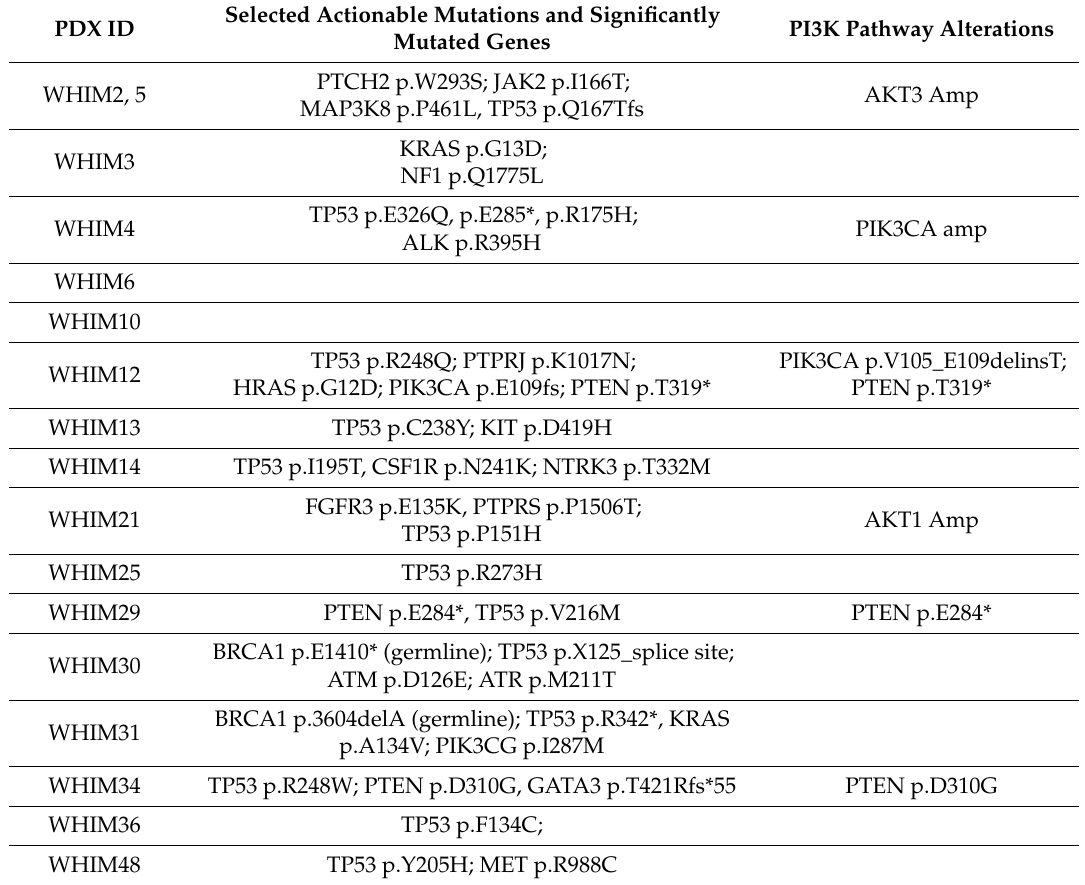
Table 1. Potential actionable mutations and genomic alterations in PI3K pathway